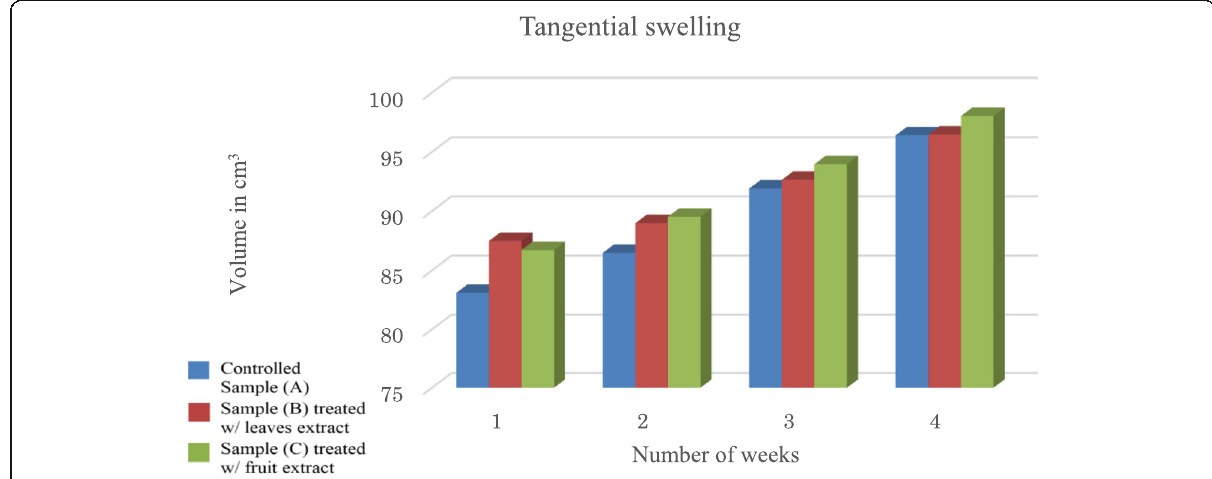
Fig. 10 Percentage increase in volume of wood samples subjected for tangential swelling